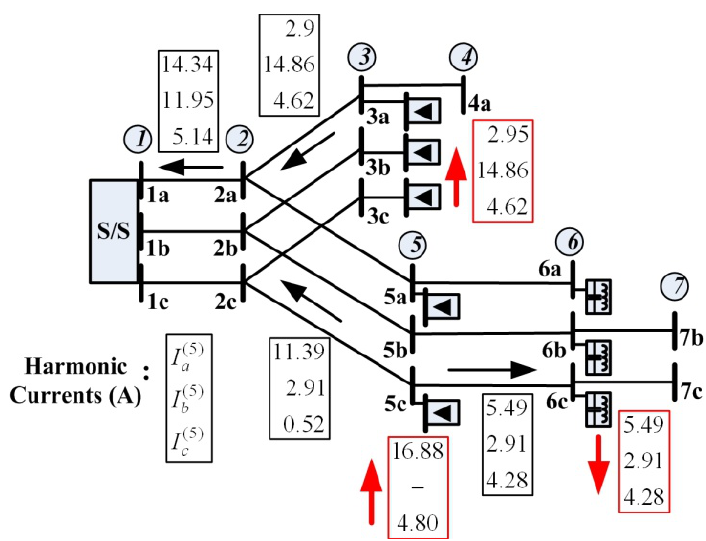
Figure 4. Branch currents of the 5 th -order harmonic order.